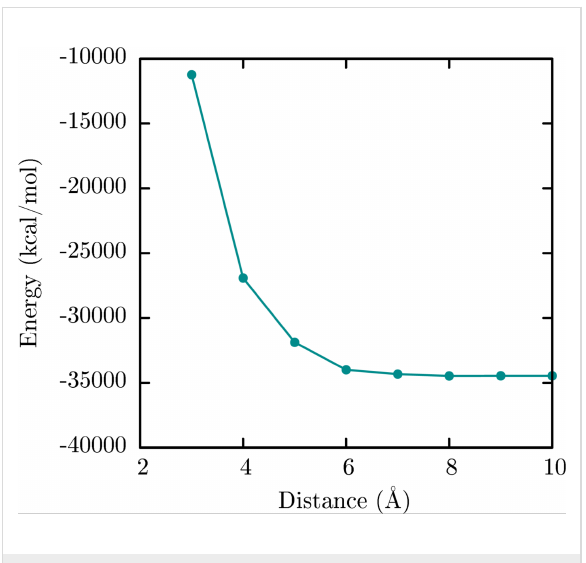
Figure 2: Evaluation of optimal separation distance between PLA chains. The energy was evaluated for two 20-monomer PLA chains at 3, 4, 5, 6, 7, 8, 9 and 10